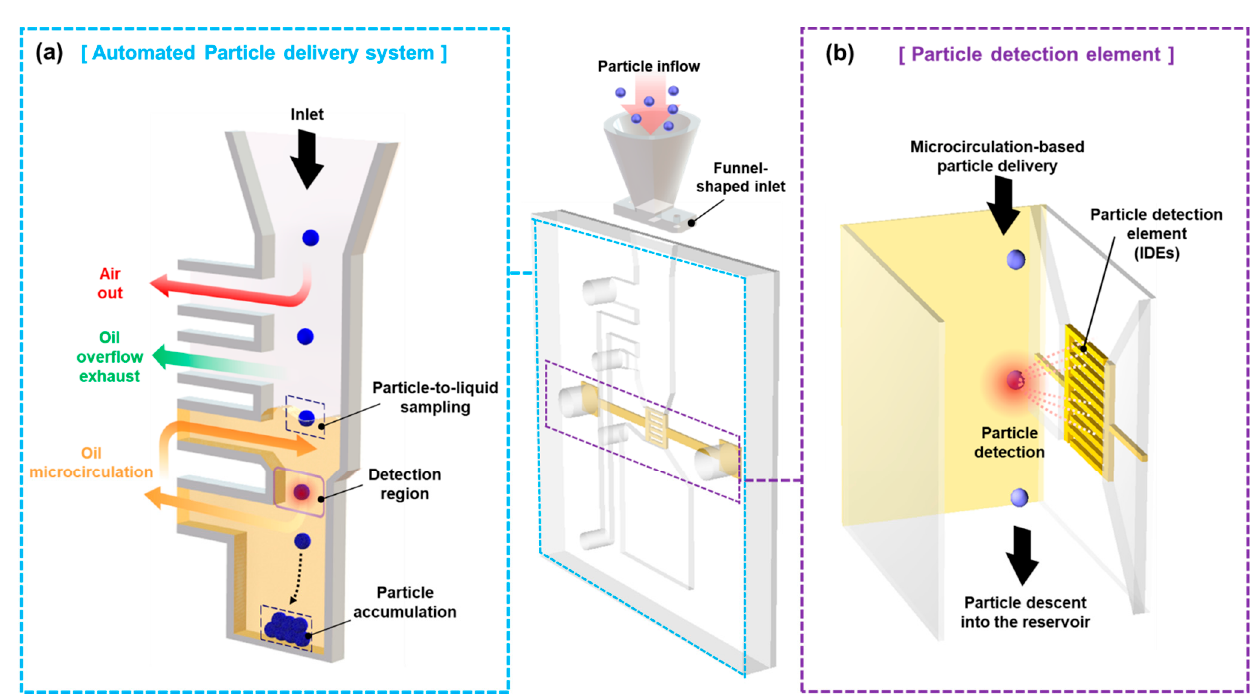
Figure 3. Schematic illustration of the proposed system. Our system consists of two sections: ( a ) an automated particle delivery system and ( b ) a particle detection element.